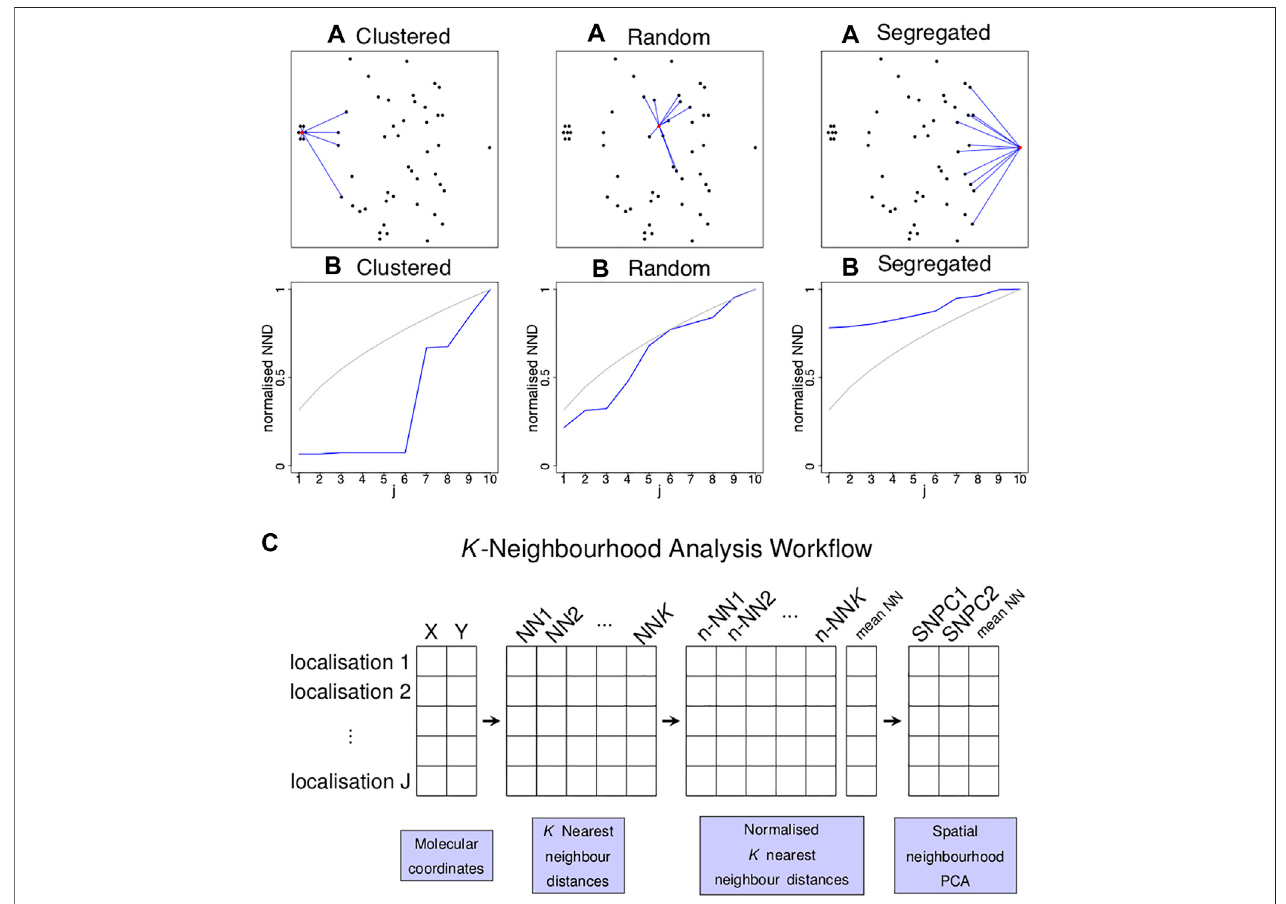
FIGURE 1 | Concept of k nearest neighbour distances to identify localised spatial organisations for each point in an image. (A) Three examples of a single point (highlighted in red) residing in a cluster of six points (left) , random point distribution (middle) and segregated from other points (left) and its K (cid:1) 10 nearest neighbours (blue lines). (B) Plots of the normalised distance from the red localisation to the j th nearest neighbour ( y -axis) against j ( x -axis) for the examples above (blue lines) and for completely spatially random (CSR) data (grey lines). Each of the three scenarios shown in (A) gives rise to a characteristic curve in (B) . (C) Schematic diagram illustrating the work fl ow of the K -Neighbourhood